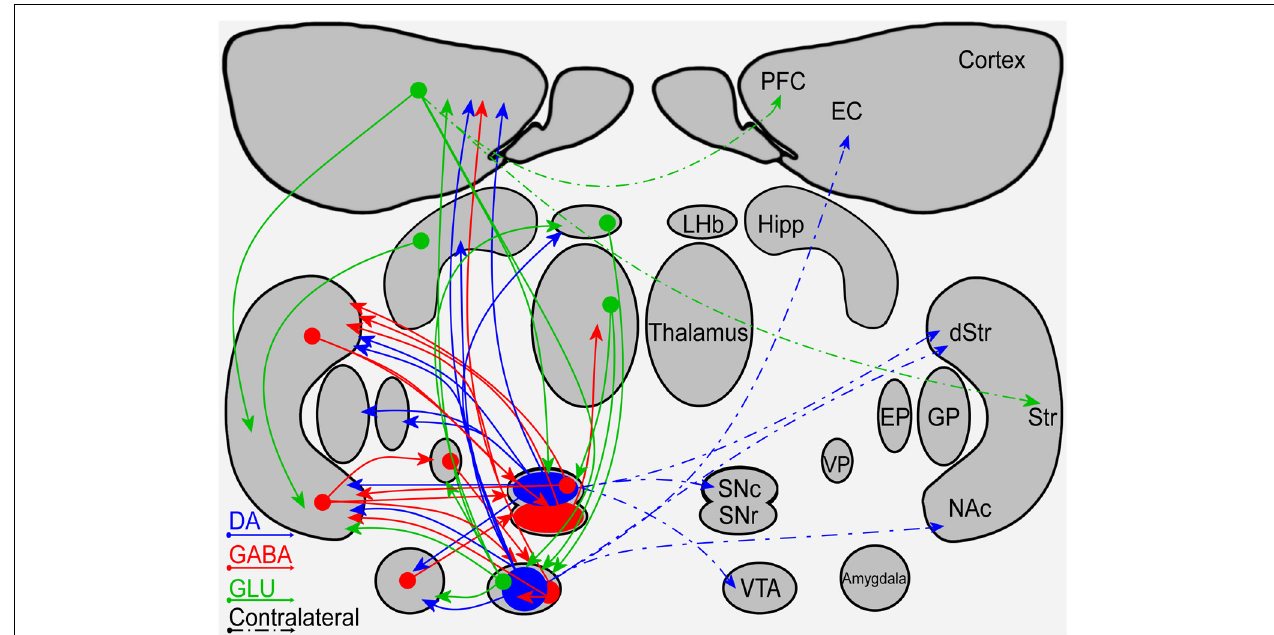
FIGURE 1 | A schematic diagram of the connectivity within and between the mesostriatal pathways and related structures. Shown are the ipsilateral (solid lines) and contralateral (dashed lines) projections of fibers containing DA (blue),GABA(red),orglutamate(green).Abbreviations:PFC,PrefrontalCortex;